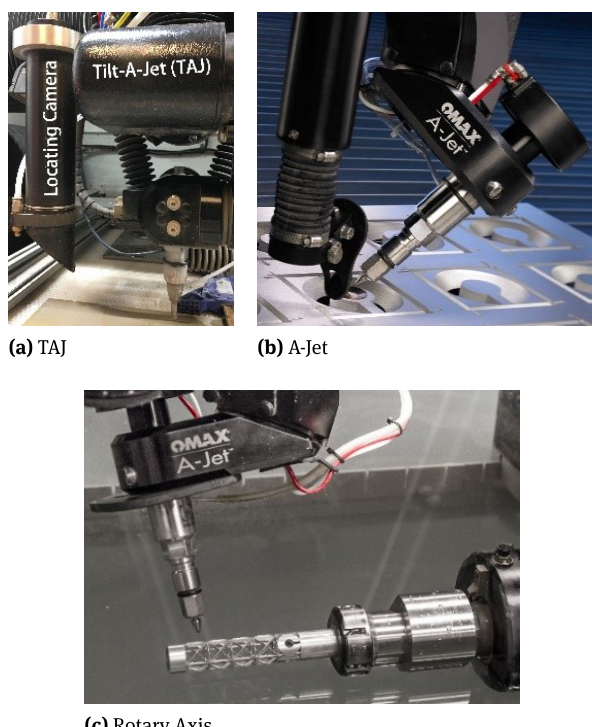
There are a set of nozzles for machining parts from macro to micro scales. Figure 3 illustrates several standard ones that are commonly used. The three on the left are the abrasive waterjet (AWJ) nozzles and the right most one is the water-only (WJ) nozzle. The numbers in the parenthe- ses are the diameters of the orifice and the mixing tube in thousandth of an inch, respectively. All the nozzles have the same length as the tip of the nozzle is the tool center point (TCP) for the A-Jet. The TCP is the pivoting center of the TAJ and the A-Jet and is fixed in position for all angles of tilting. For extremely delicate materials with very low tensile strength, a mechanical drilling head consisting of a drill bit is available to be attached to the waterjet system. Pierc- ing ofthe partis performed priorto machining anyinternal features. A position optical locator (POL) as illustrated in Figure 2a is used to reposition accurately the nozzle to the centers of predrilled